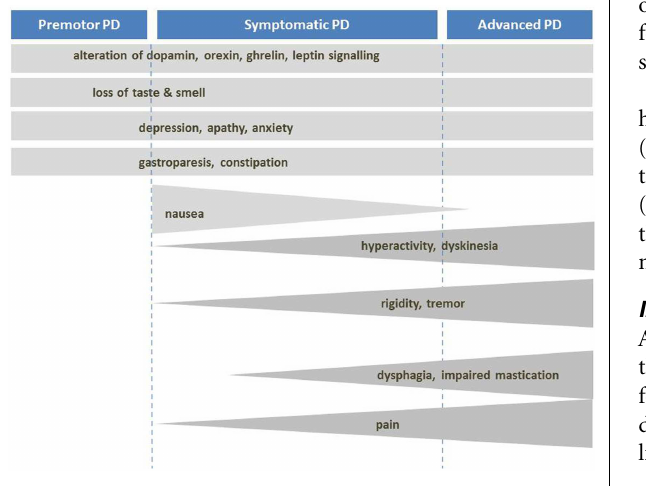
FIGURE 2 | Mechanisms of body weight loss in PD . Mechanisms of body weight loss in Parkinson’s disease according to the stage of the disease. Factors with important contribution to weight loss are dark